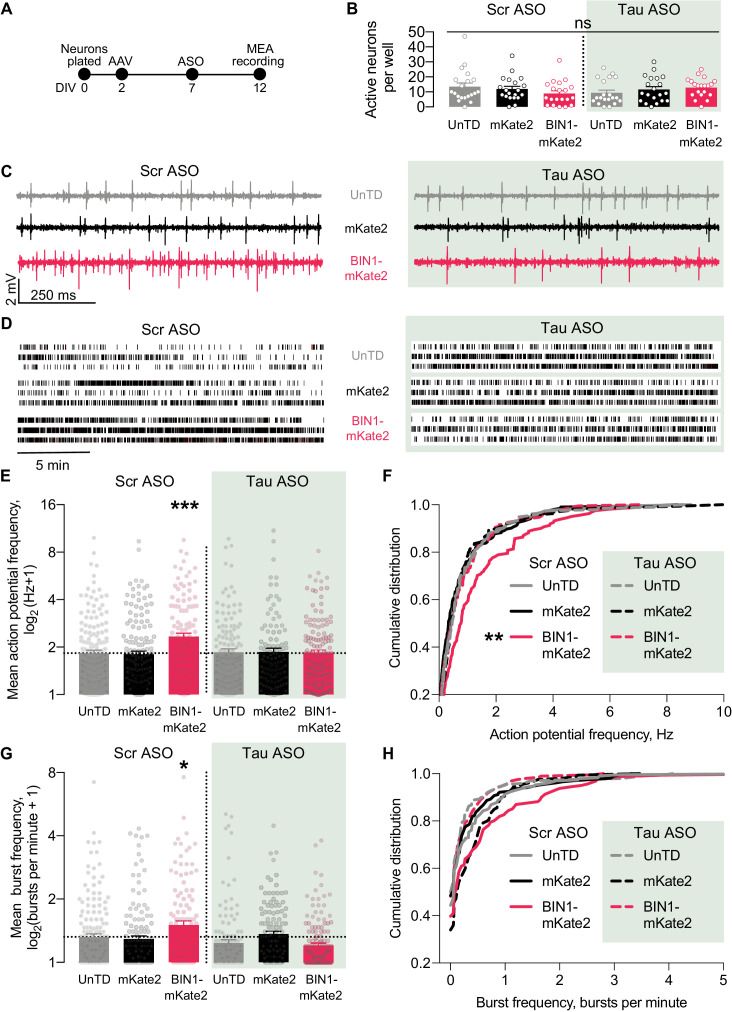
Tau reduction prevents network hyperexcitability induced by BIN1.(A) MEA experimental timeline: neurons were plated on DIV 0, virally transduced on DIV 2, treated with Tau or scrambled ASO on DIV 5, and electrophysiologically recorded on DIV 12. (B) The number of active neurons was not different between groups (n = 6–8 coverslips per group from three different neuronal harvests; two-way ANOVA, main effect of Tau ASO p=0.9140, main effect of AAV-BIN1-mKate2 p=0.9026, interaction p=0.1101). (C) Representative LFP traces of MEA recordings. (D) Representative raster plots of MEA recordings. (E) Tau reduction prevented BIN1-induced network hyperexcitability as measured by mean action potential frequency (n = 159–230 neurons from 6 to 8 wells per group from three different neuronal harvests; two-way ANOVA, BIN-Tau interaction **p=0.0073, main effect of Tau ASO p=0.0761, main effect of AAV-BIN1-mKate2 *p=0.0130, Sidak’s multiple comparisons test: UnTd:Scr ASO vs. BIN1-mKate2:Scr ASO ***p=0.0010). (F) Cumulative distribution of the mean action potential frequency (Kolmogorov-Smirnov test on cumulative distribution, UnTD-Scr ASO vs. BIN1-mKate2-Scr ASO **p=0.0028). (G) Tau reduction prevented BIN1-induced network hyperexcitability as measured by mean burst frequency (n = 159–230 neurons from 6 to 8 wells per group from three different neuronal harvests; two-way ANOVA, BIN-Tau interaction ***p=0.0005, main effect of Tau ASO **p=0.0066, main effect of AAV-BIN1-mKate2 p=0.2286, Sidak’s multiple comparisons test: UnTd:Scr ASO vs. BIN1-mKate2:Scr ASO *p=0.0227). (H) Cumulative distribution of the burst frequency (Kolmogorov-Smirnov test on cumulative distribution, UnTD-Scr ASO vs. BIN1-mKate2-Scr ASO, p=0.1107). All data are expressed as mean ± SEM.